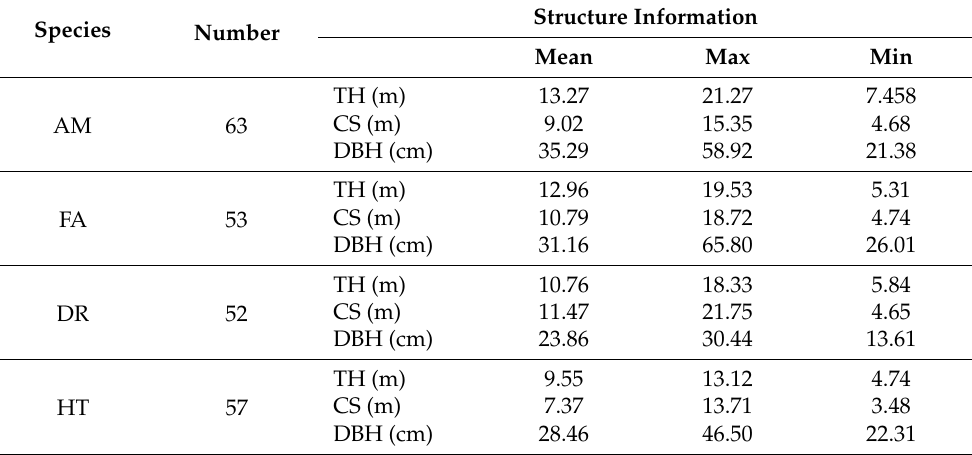
Figure 2. Examples of point cloud of four species. Four species from left to right are Aleurites moluc- cana, Ficus altissima, Delonix regia and Hibiscus tiliaceus , respectively. Table 1. Basic structural information of trees of four species. Mean, Max and Min are average, max- imum and minimum values of TH, CS and DBH, respectively.